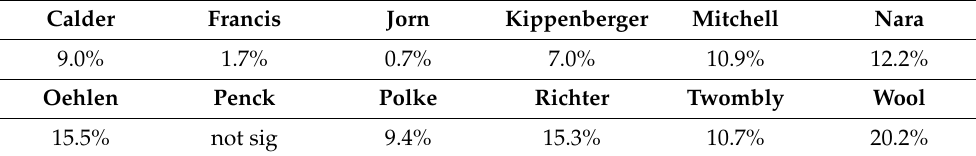
Table 7. Annual rates of appreciation in real US Dollar terms for sales by each